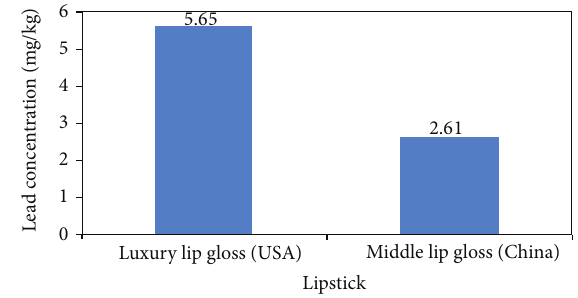
Figure 6: Lead concentration (mg/kg) in lipsticks. Suggested safe levels of Gondal et al. (0.5ppm), Expert Panel 2007 (0.2ppm), and Germany